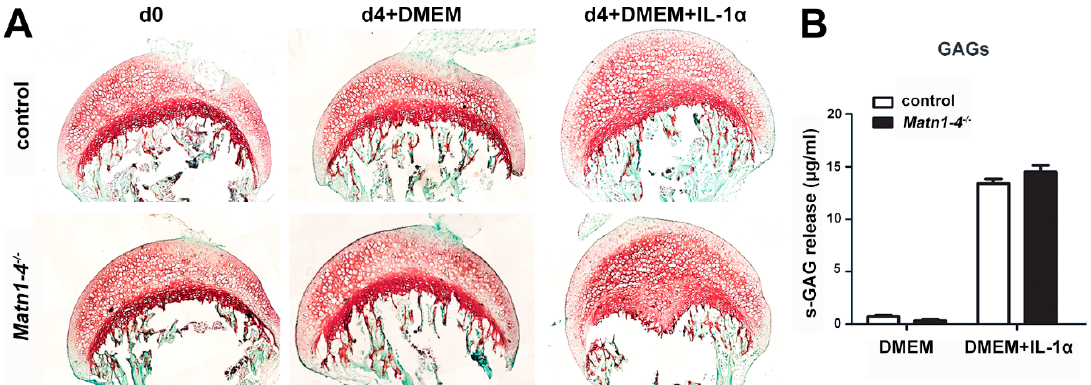
Figure 9. Matrilins are not involved in the interleukin-1-mediated proteoglycan loss of the articular cartilage. ( A ) Safranin-O and Fast Green staining of hip explants after culturing for 4 days (d4) with or without 10 ng / mL IL-1 α . Note the similar loss of proteoglycans at the articular cartilage surface after IL-1 α stimulation in control and Matn1-4 − / − mice. ( B ) Quantification of the sulfated GAG release